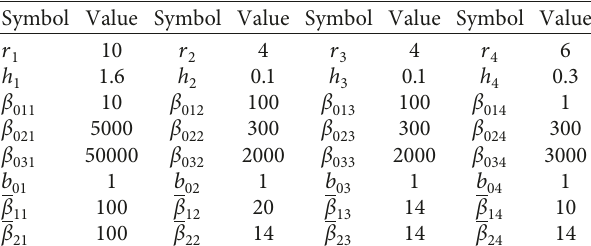
Table 7: Controller parameters in the